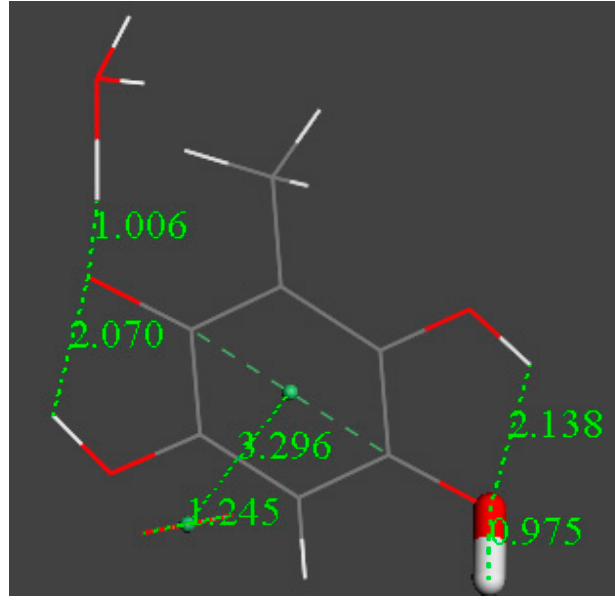
Figure 9. An additional H 3 O + is reacted at the remaining O(carbonyl) of [embelin-model-H] − , and the proton is also captured. Δ G = − 38.3 kcal/mol.